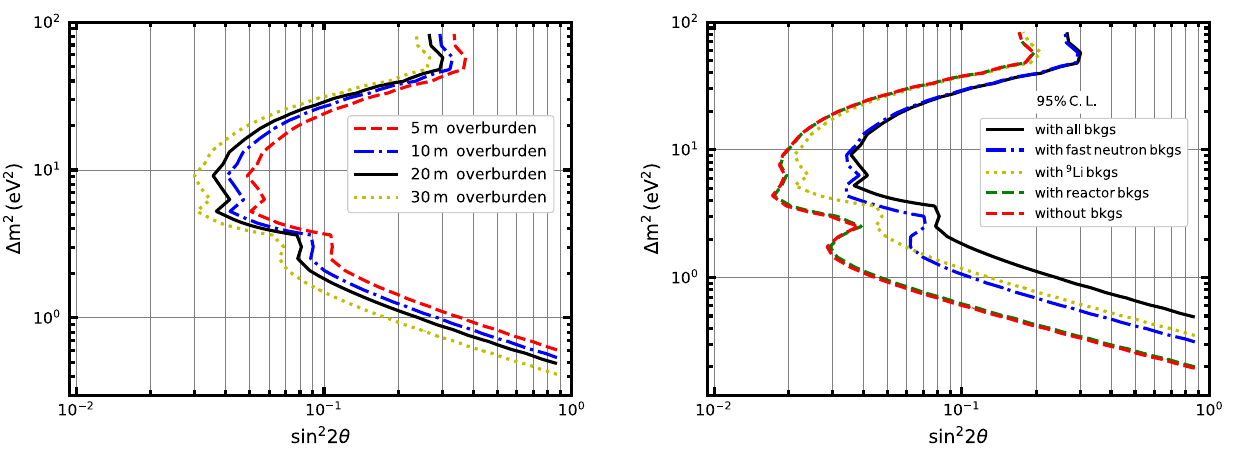
Fig. 5 The 95% C.L. sensitivity curves of the sterile neutrino search with different overburdens. The red dashed curve corresponds to an overburdenof5 m,thebluedash-dottedcurvetoanoverburdenof10 m, the black solid curve to 20 m, and the yellow dotted curve to 30 m. A five year run and 90% duty factor are assumed